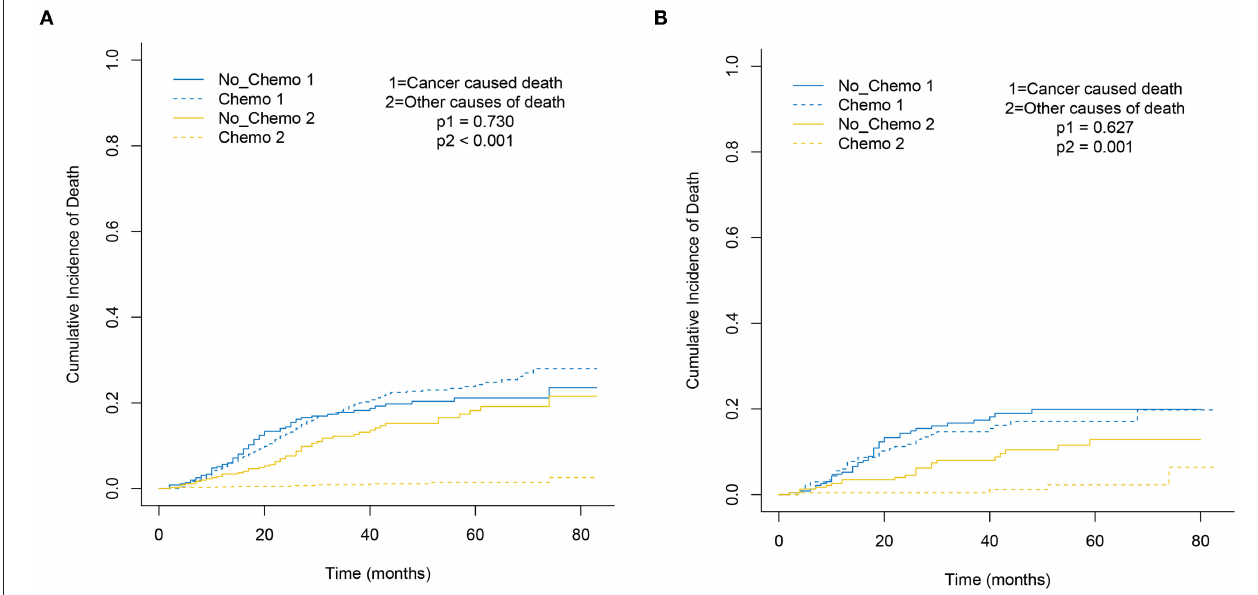
Frontiers in Oncology |